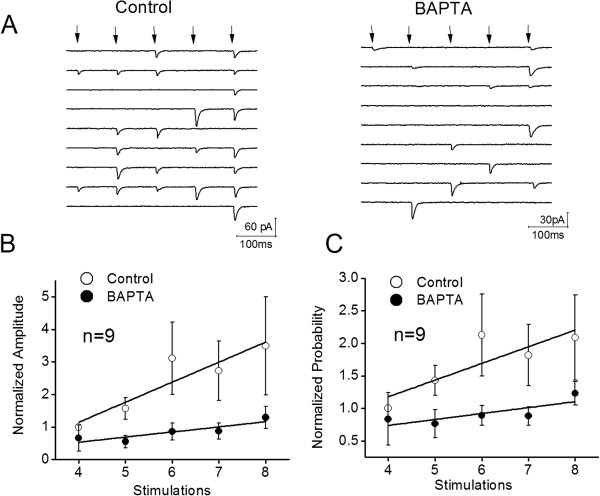
The reduction of presynaptic Ca2+ by infusing BAPTA attenuates the increment of release probability of glutamate release and the facilitation of synaptic transmission. A) Left panel shows the waveforms of uEPSC4 ~ 8 induced by sequential spikes (pointed by arrows) at a synapse under control. Calibration bar, 60 pA/100 ms. Right panel shows the waveforms of uEPSC4 ~ 8 induced by these sequential spikes (arrows) at this synapse under BAPTA infusion. Calibration bar, 30 pA/100 ms. B) shows the normalized uEPSC amplitudes under the conditions of control (opened symbols) versus BAPTA infusion (filled symbols; n = 10). C) shows the normalized probabilities of releasing glutamate under the conditions of control (opened symbols) versus BAPTA infusion (filled symbols; n = 10). It is noteworthy that the experiments were done at the synapses with low probability, such that uEPSC4 ~ 8 were analyzed. Lines in B and C illustrate linear dynamical fitting.